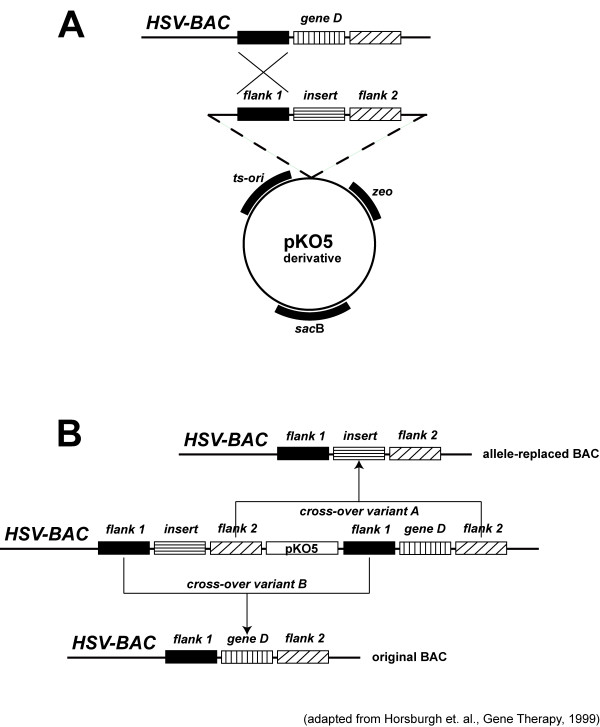
Schematic diagram of allele replacement strategy using vector pKO5. (A) Features of a typical allele replacement vector include a positive selection marker for antibiotic resistance marker (zeo), a temperature-sensitive origin of replication (ts-ori), a negative selection marker (sacB) and flanking sequences to targeting cross-over at hypothetical gene D. Incubation at non-permissive temperature (43°C) and selection on Zeocin/Chloramphenicol lead to co-integration through homologous recombination (single cross-over). (B) Diagram of the resultant single-crossover recombinant BAC and the two possible forms following resolution. Incubation at permissive temperature (30°C) and selection on Zeocin/Sucrose lead to resolution of the co-integrate, excision of the plasmid through homologous recombination (double cross-over).